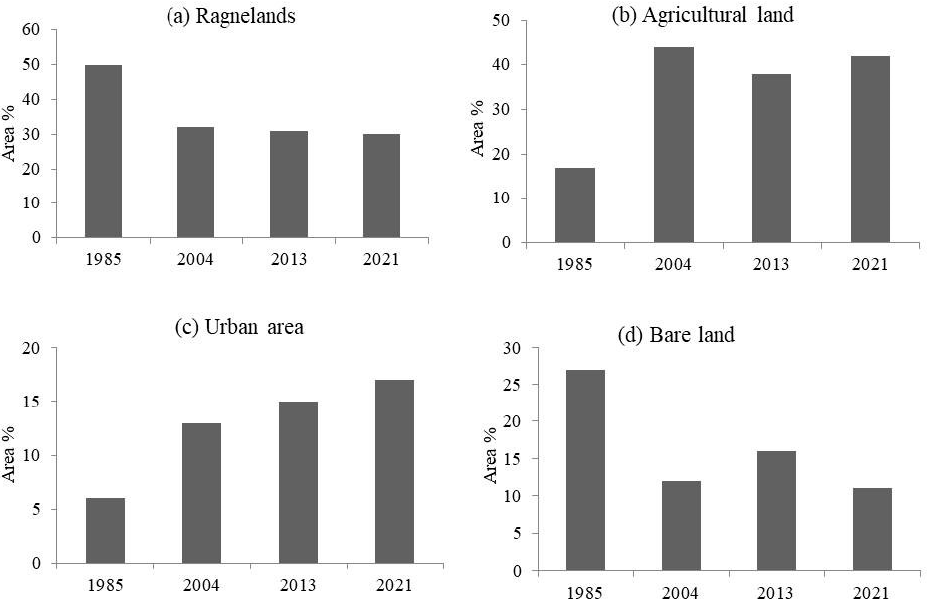
Figure 3. Graphs illustrating the proportion of each land cover class over the study period.